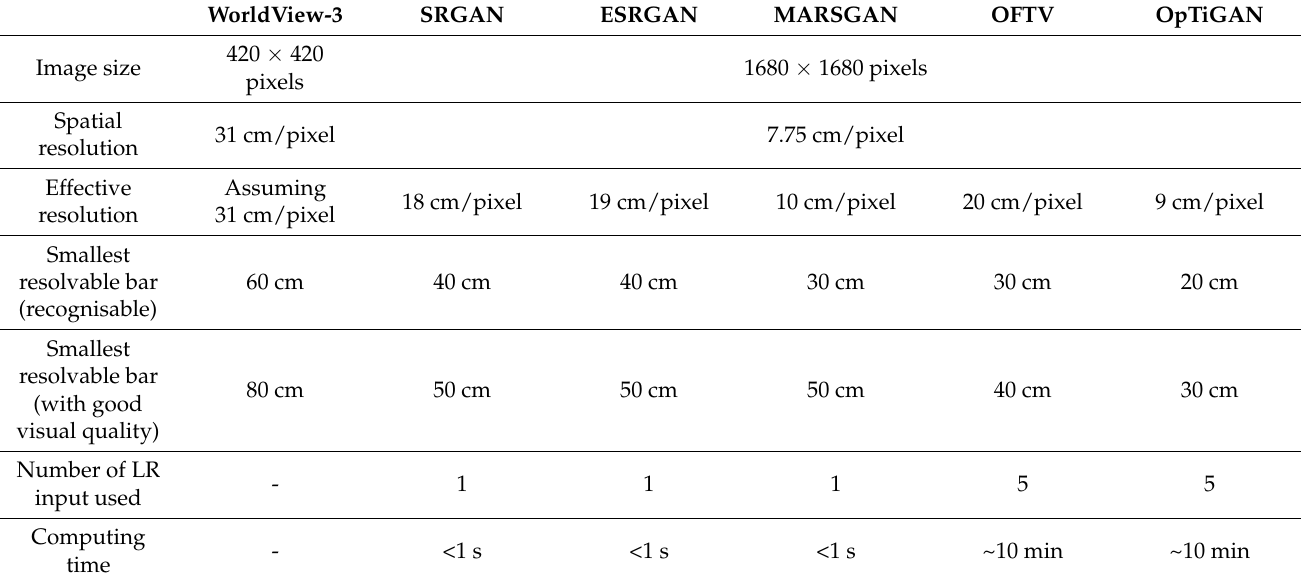
Table 4. Summary of the effective resolution derived from Figure 7 and Table 3, the smallest resolvable bar pattern targets observed from the WorldView-3 image and each of the SRR results, in comparison to Figure 5, as well as the number of input images used and computing time for the Baotou Geocal